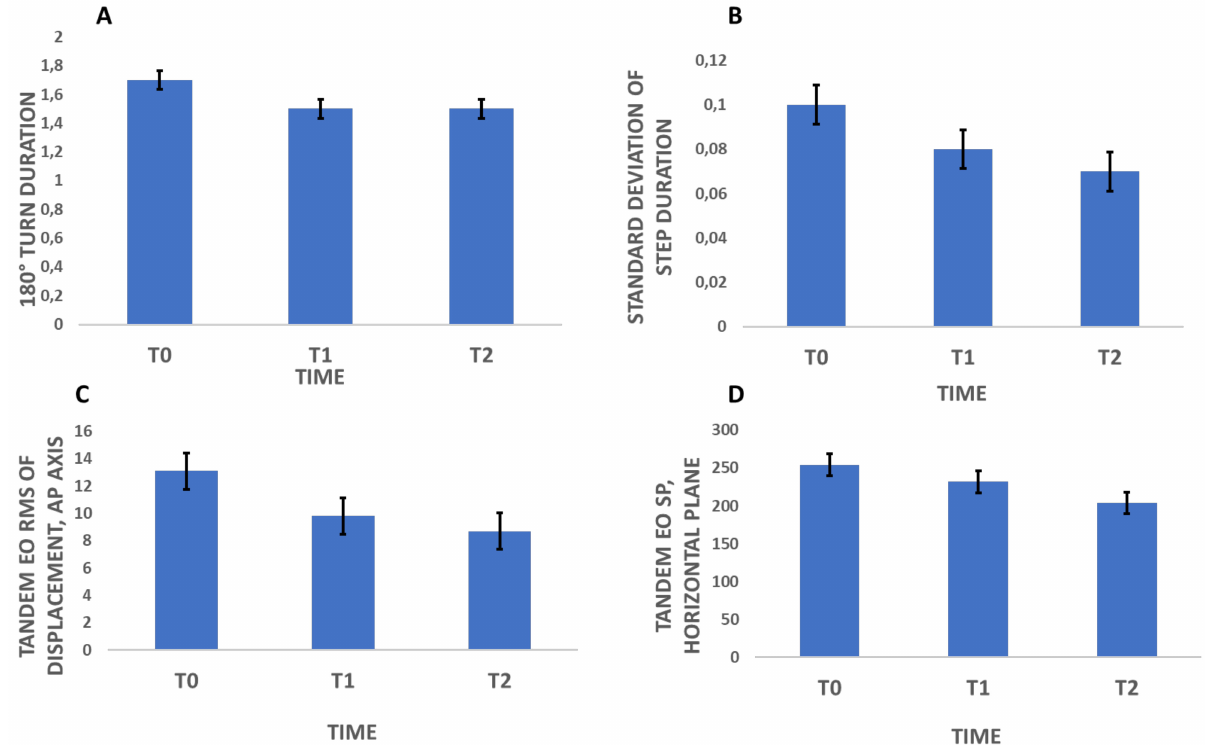
Figure 3. Mean Values of the variables that significantly changed after plantar stimulation (180 ◦ turn duration ( A ), Standard deviation of step duration ( B ), Tandem EO RMS of displacement, AP axis ( C ) and Tandem EO SP, horizontal plane ( D